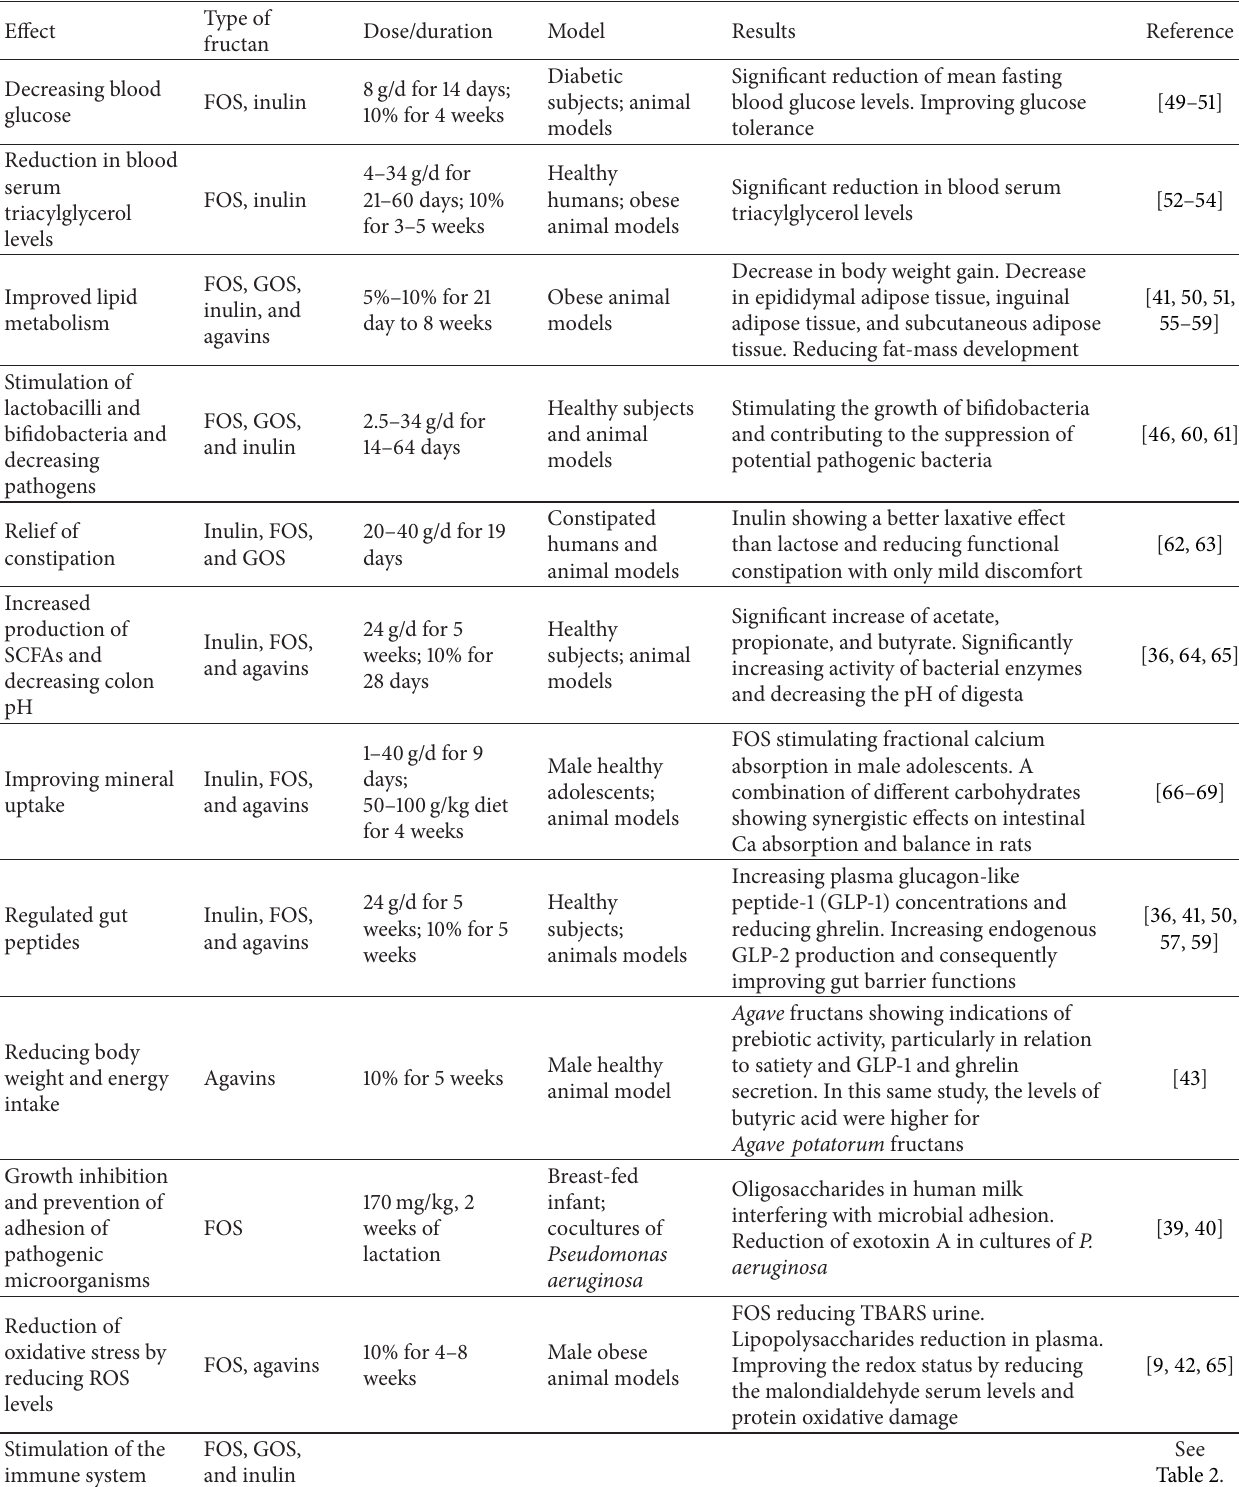
Table 1: Main prebiotic effects of fructans in in vitro and in vivo